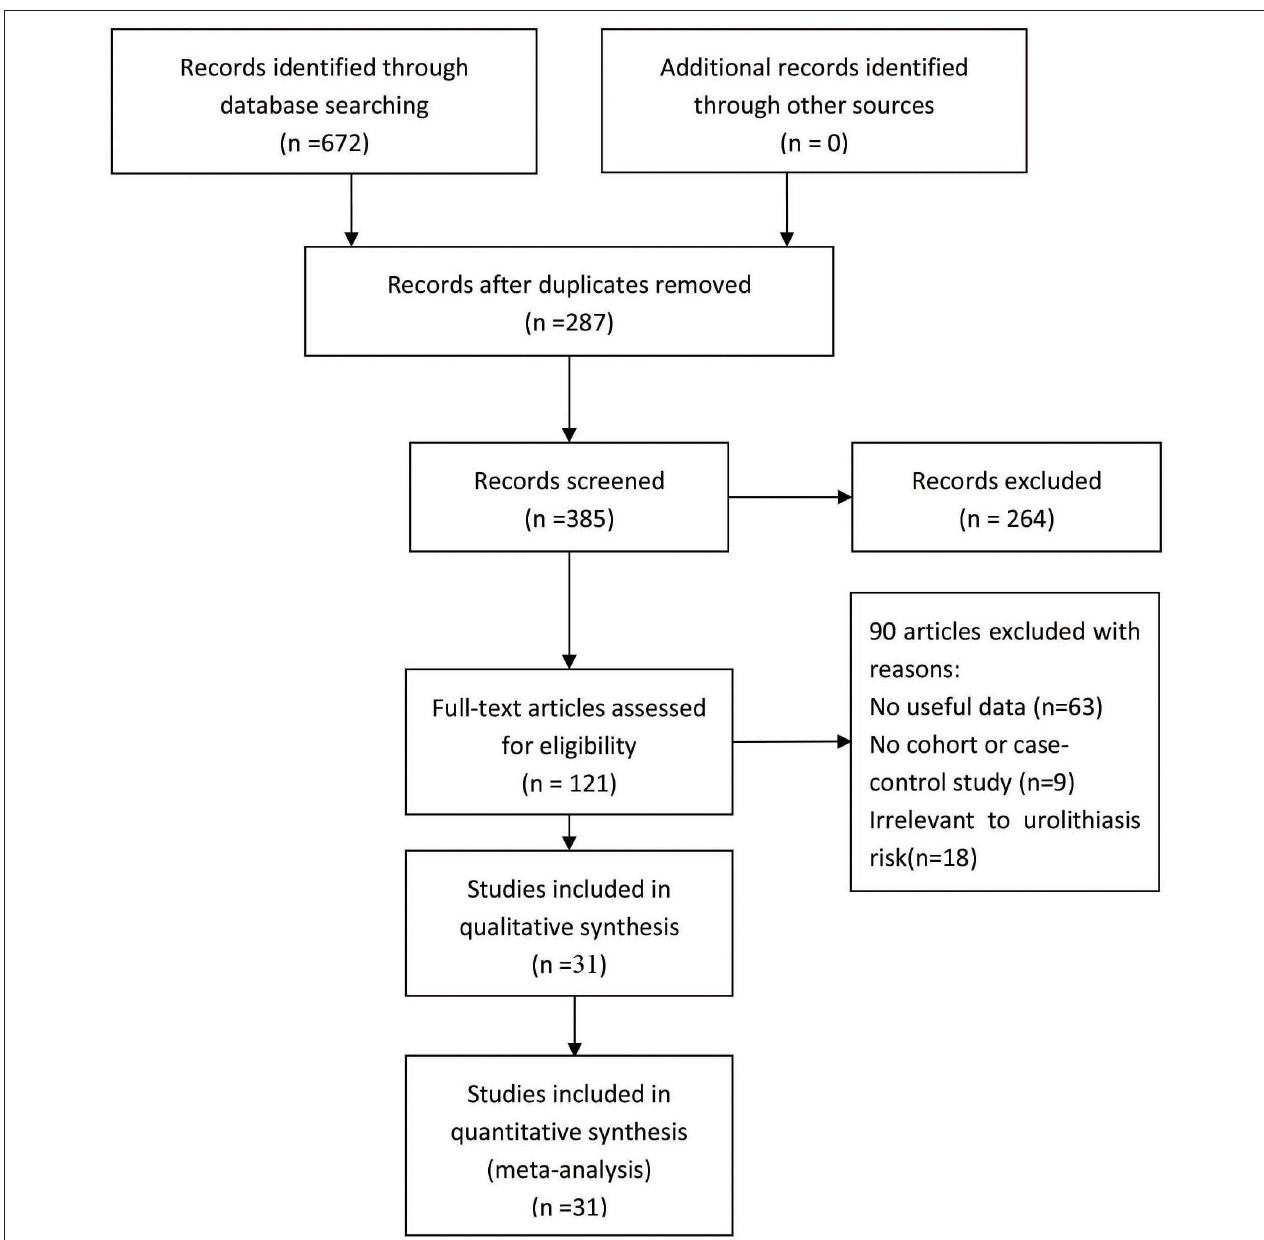
FIGURE 1 | Flowchart illustrating the search strategy for VDR variants and the urolithiasis